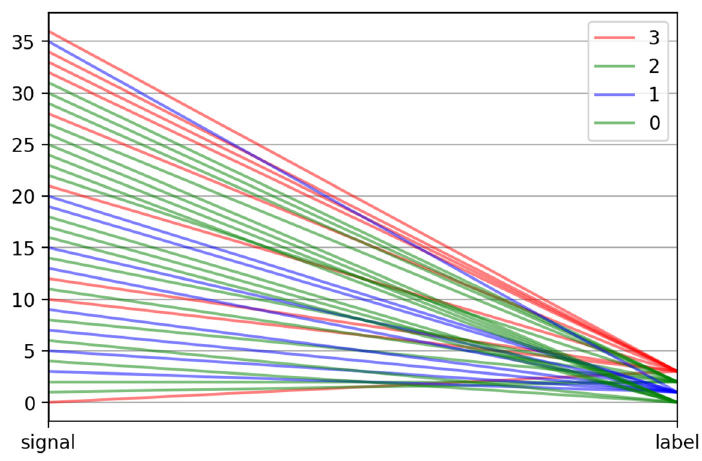
Figure 6. Mapping of 37 PAH patients’ data to 4 clusters marked with four colors.